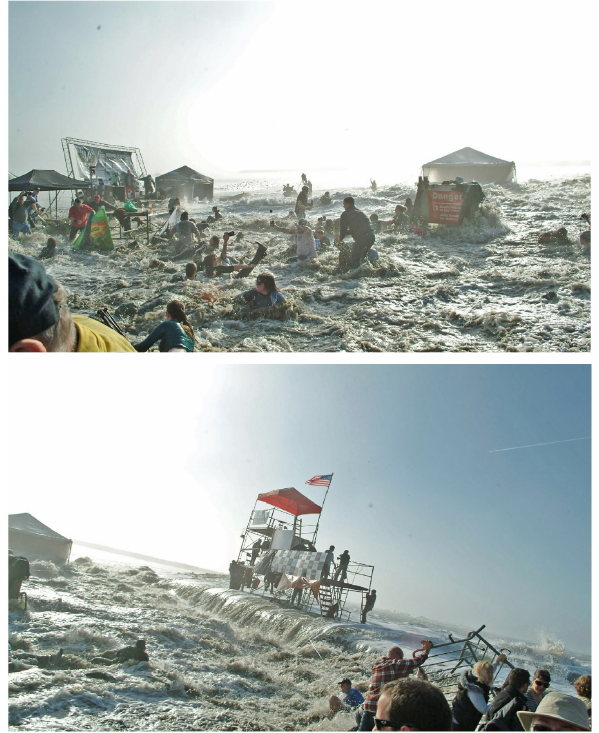
Figure 6. Damage caused by freak